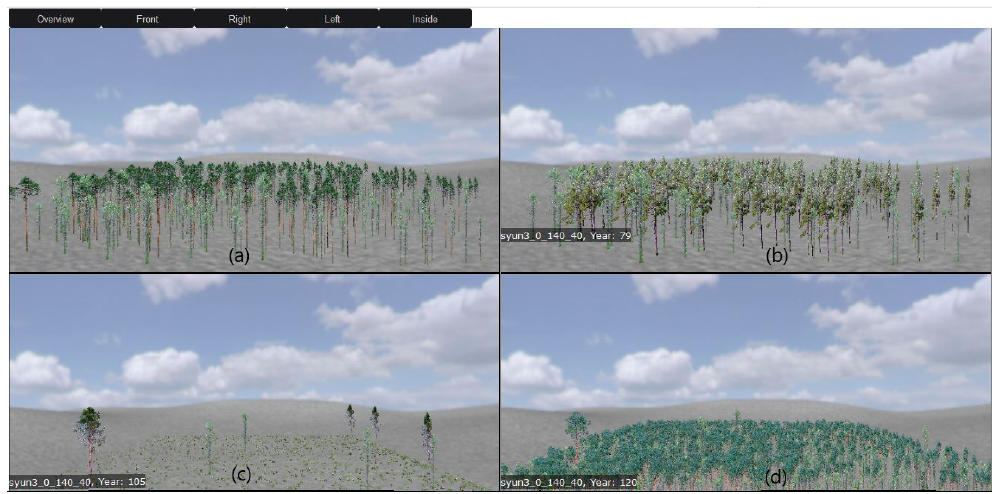
Figure 11. 3D viewer: stand comparison. Di ff erent states of the stand can be compared in a single view. The figure shows clockwise the initial state of the stand ( a ), year 79 of the simulation ( b ), year 105 ( c ), five years after clear cut, and year 120 ( d